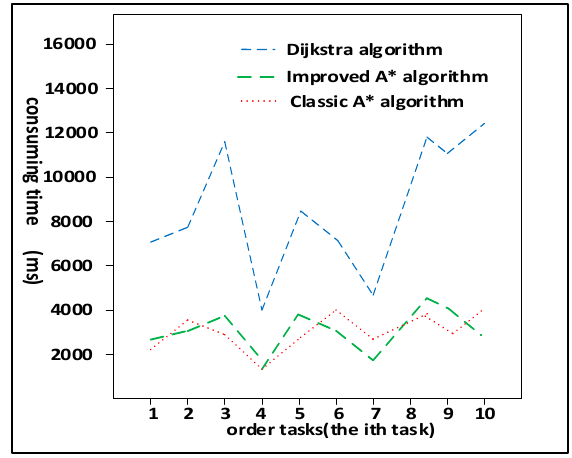
Figure 9. Time-consuming comparison